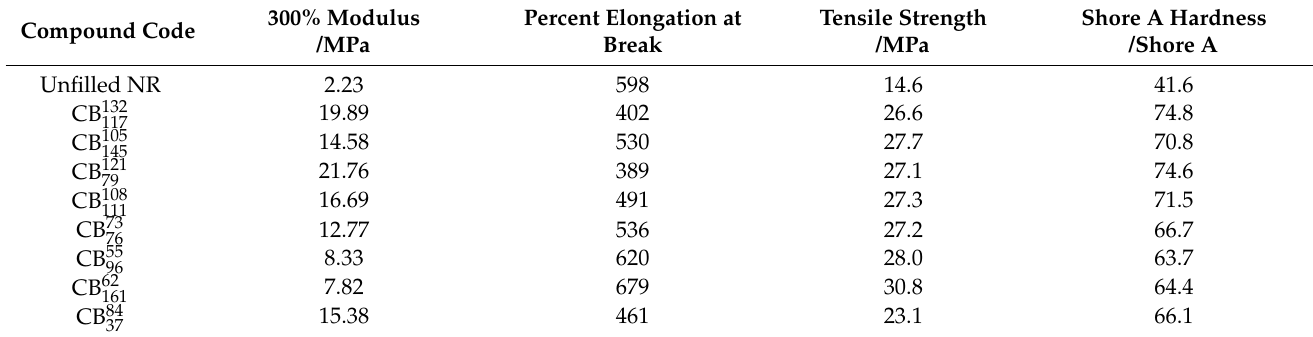
Table 3. Summary of the hardness and tensile properties of the various rubber compounds.